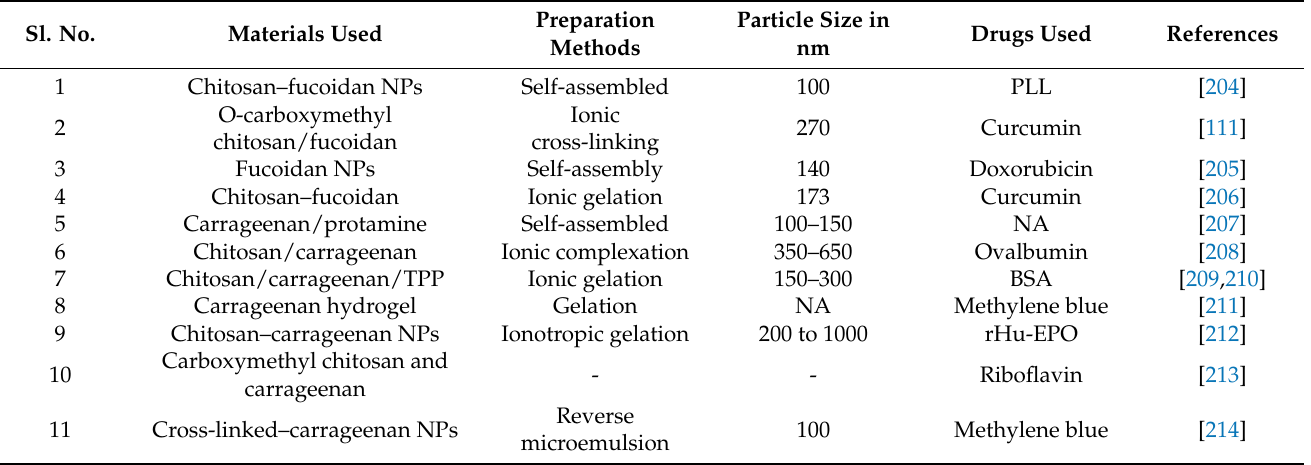
Table 4. Nanoparticle synthesis by using sulfated polysaccharides and its impact on the cancer therapeutic